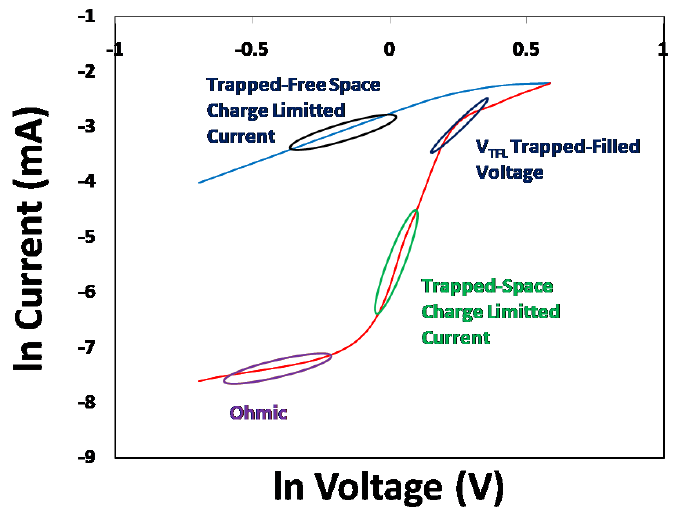
Figure 4. ln Current vs. ln Voltage characteristics of the Cu/PEPC-TCNQ/Ag diode, which clearly shows possible charge transport mechanisms as: (1) ohmic region; (2) trapped-space charge region; (3) trapped-filled voltage region; and (4) trapped-free space charge